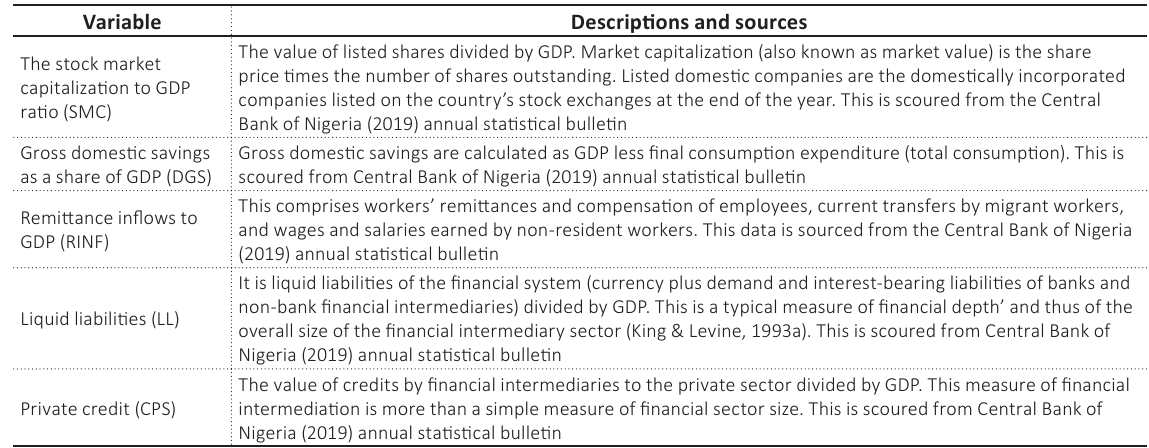
Table 1. Description of variables